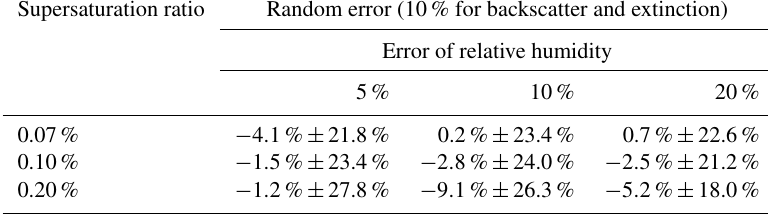
Table 6. Mean and 1 standard deviation (SD) values (mean ± SD) of relative errors in retrieved CCN number concentrations at different supersaturations with different random error conditions. The uncertainty of backscatter and extinction coefficients of all the tests is 10%, and the uncertainties of relative humidity are 5%, 10%, and